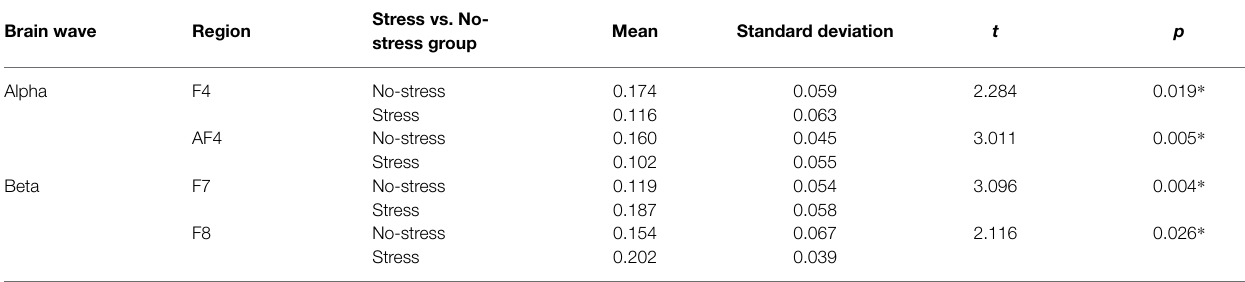
TABLE 6 | Comparing brain waves and activated regions during a cognitive mapping test. Brain wave